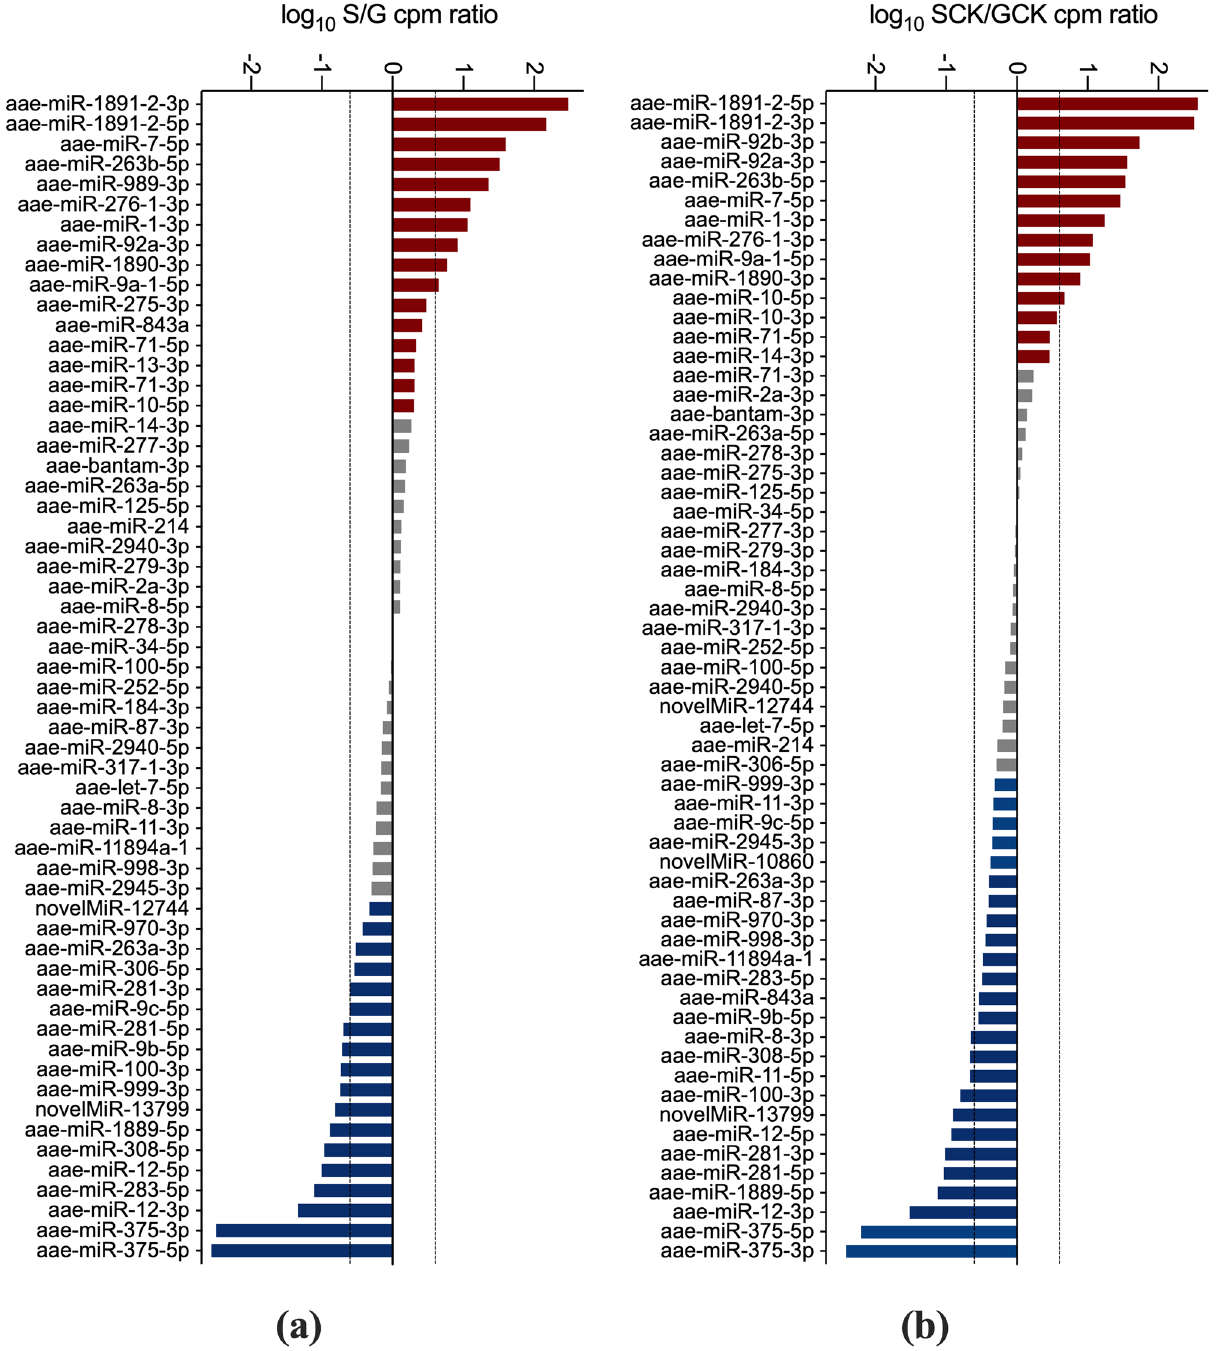
Figure 5. Asymmetric distribution of miRNAs in saliva and salivary glands of uninfected and CHIKV-infected Ae. aegypti . Comparison of the mean CPM values of the 50 most abundant miRNAs in saliva and salivary glands of uninfected and chikungunya-infected mosquitoes. The log10 of the S/G ( a ) and SCK/GCK ( b ) mean CPM ratios are reported. MicroRNAs with a ratio ≥ 2.0 are shown in red, those with a ratio ≤ 0.5 in blue and miRNAs with ratios > 0.5 and < 2.0 in grey. Dashed lines mark the limits of 4-fold